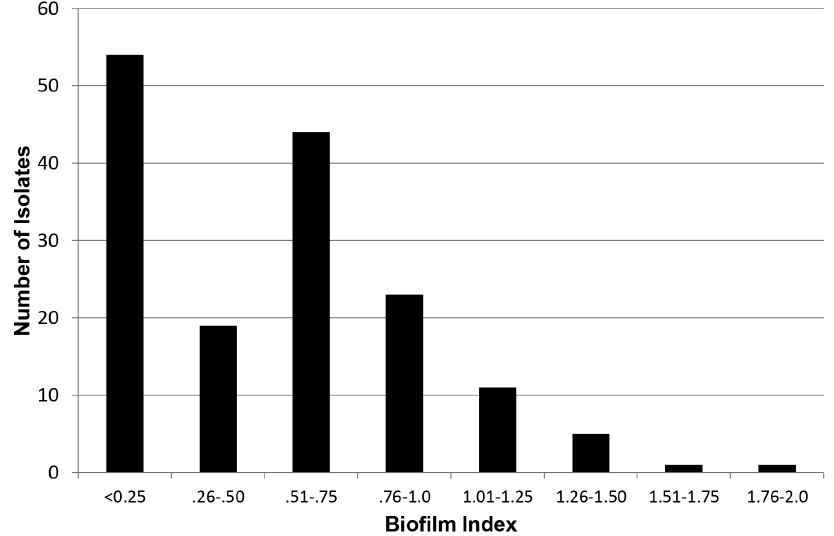
Figure 1. Histogram of biofilm forming ability of clinical Enterococcusfaecalis isolates. 158 clinical E. faecalis isolates, including isolates from the clinical microbiology laboratory and fecal samples from healthy volunteers, were tested in the 96-well polystyrene dish biofilm assay using TSB without glucose and 24-hour incubation. To control for strain variation in planktonic growth, results are shown as each isolate’s biofilm index (Methods).